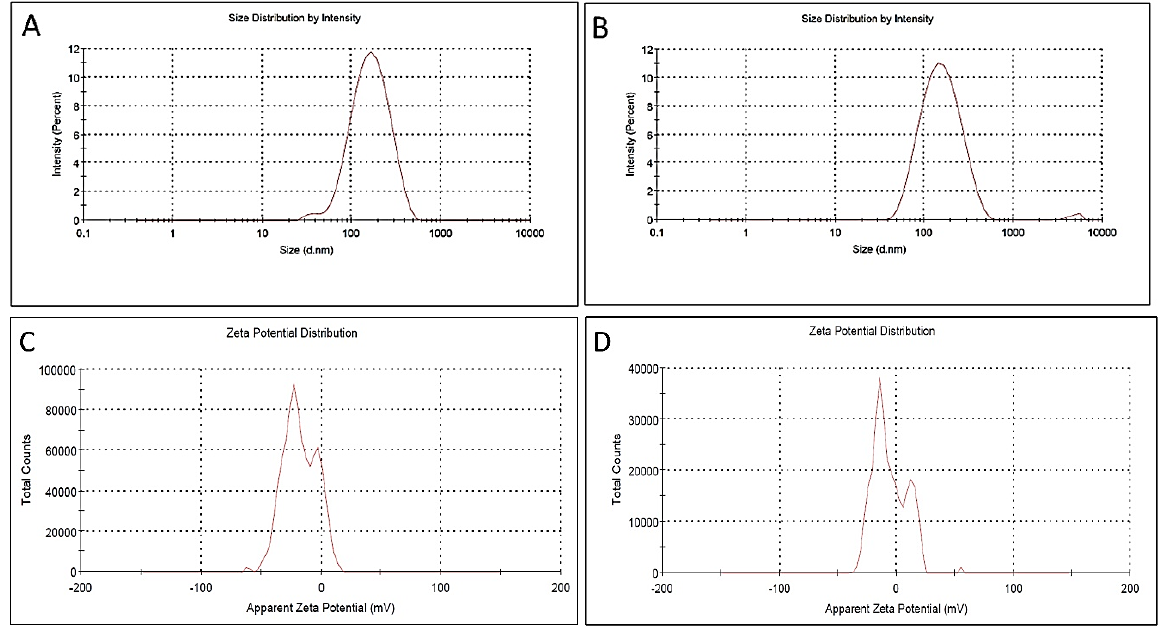
Figure 3. HR-TEM of silver nanoparticles biosynthesized using the extracts, AngTE and AnsTE; ( A , D ) at 100 nm, ( B , E ); at 20 nm, ( C , F ): SAED for Ang-AgNPs and Ans-AgNPs in the same order.